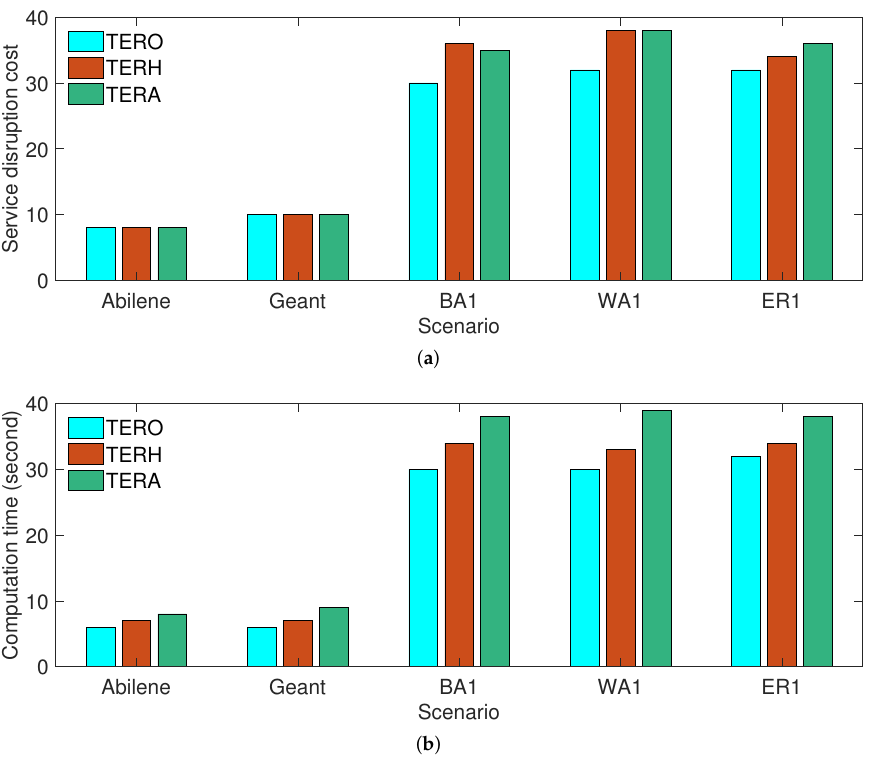
Figure 2. Performance comparison of TERO, TERH and TERA when a failure scenario is fixed. ( a ) Service disruption cost; ( b ) Computation time.